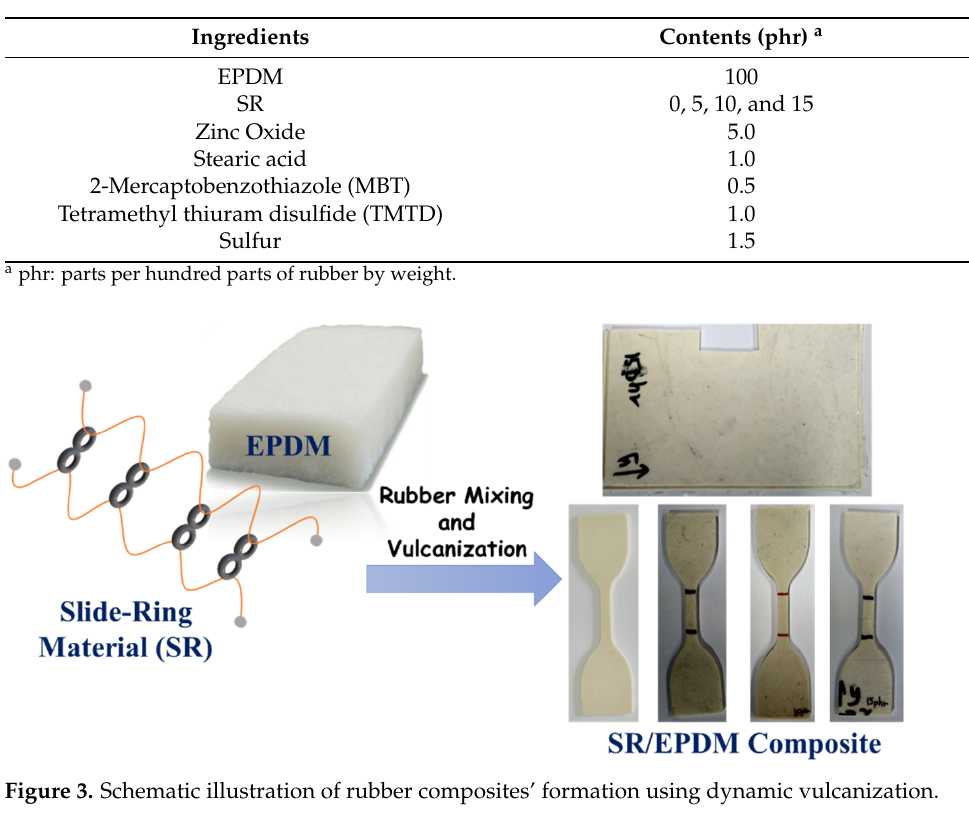
Table 1. Typical compounding formulation of SR/EPDM composites.